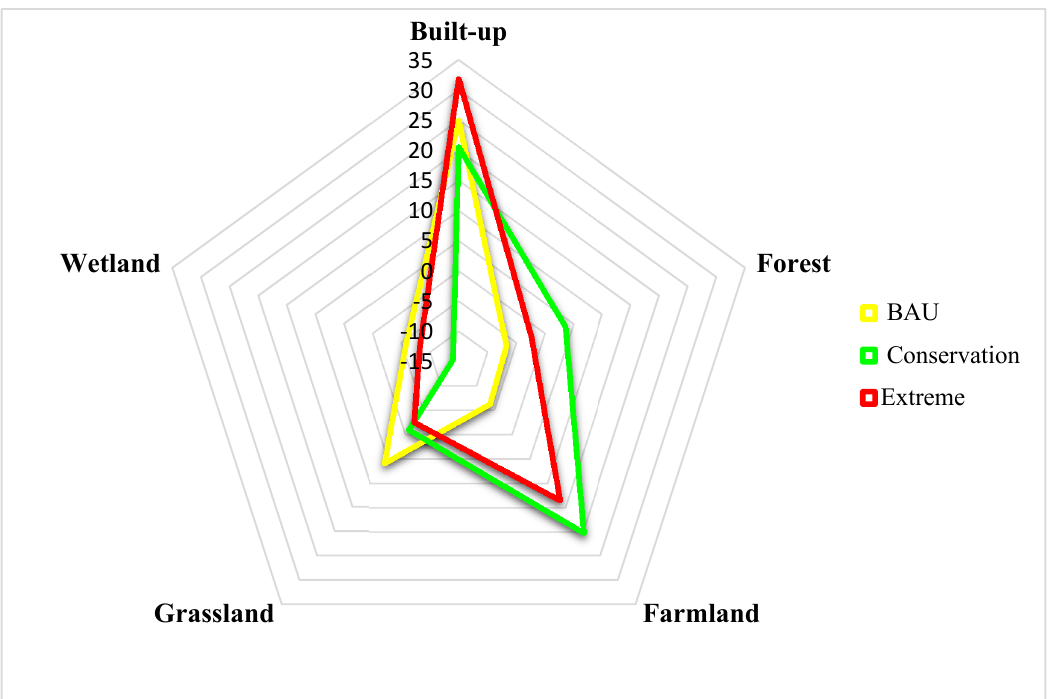
Table 9. Areal changes from 2018–2027 under the three scenarios (BAU: business as usual scenario; CONSV: conservation scenario; EXTRM: extreme scenario).